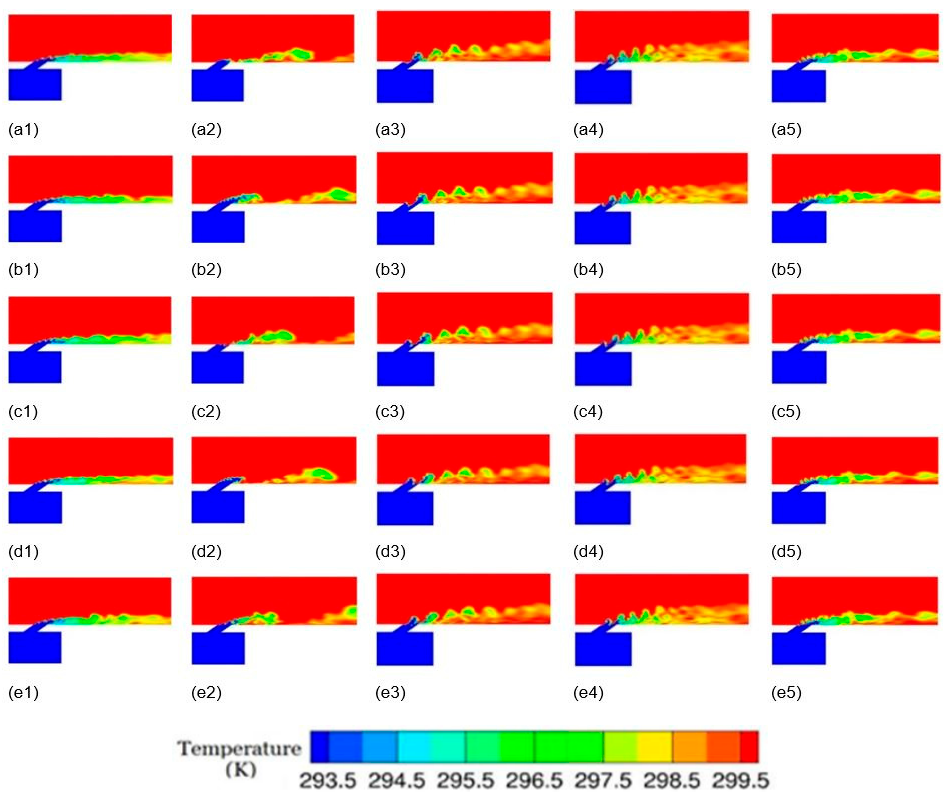
Figure 16. ( a1 – e1 ) The instantaneous temperature contours for the central cross section using the FLUENT, LES, Smagorinsky–Lilly model for M = 0.5, 2 Hz [28]. ( a2 – e2 ) The instantaneous temperature contours for the central cross section using the FLUENT, LES, Smagorinsky–Lilly model for M = 0.5, 32 Hz [28]. ( a3 – e3 ) The instantaneous temperature contours for the central cross section using the FLUENT, LES, Smagorinsky–Lilly model for M = 0.5, 180 Hz [28]. ( a4 – e4 ) The instantaneous temperature contours for the central cross section using the FLUENT, LES, Smagorinsky–Lilly model for M = 0.5, 268 Hz [28]. ( a5 – e5 ). The instantaneous temperature contours for the central cross section using the FLUENT, LES, Smagorinsky–Lilly model for M = 0.5, 536 Hz [28]. ( a ) t /period = 0 ( b ) t /period = 0.2 ( c ) t /period = 0.4 ( d ) t /period = 0.6 ( e ) t /period = 0.8.